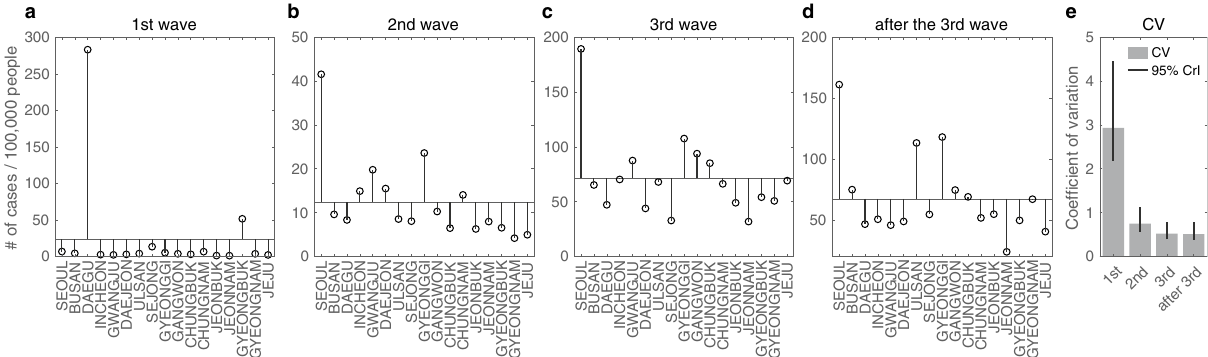
Figure 7. Regional variation in infection rate relative to the average rate. ( a – d ) show the rate of incidence per 100,000 people relative to the average rate for the first wave, second wave, third wave and after the third wave, respectively. The only incidence rates of Daegu and Gyeongbuk are shown to be higher than average. After the first wave, the incidence rates of Daegu and Gyeongbuk decreased to be under the average. The coefficient of variation (CV), defined as the ratio of the standard deviation to the mean is plotted in ( e ). Grey bar and black vertical line represent the CV of each period and its 95% credible interval (CrI), respectively. The CV estimated for each period is found to be 2.93 (95% CrI: 2.19–4.47), 0.75 (0.56–1.14), 0.52 (0.39–0.79), and 0.51 (0.38–0.77), respectively. This result shows that regional variation in the rate of incidence per 100,000 population becomes gradually uniform over Fig. 7a), only the rate of incidence for Daegu and Gyeongbuk is shown to be higher than average. After the first wave, the rate of incidence for Daegu and Gyeongbuk becomes below the average, whereas that of Seoul and